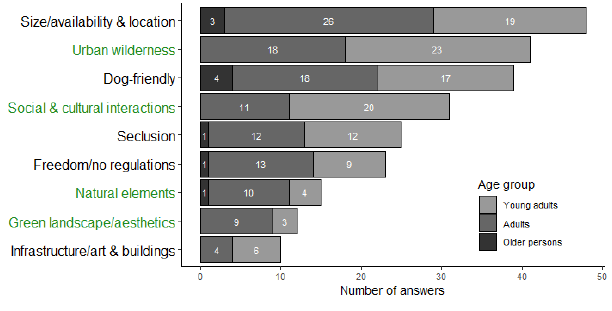
Fig. 4 . Frequencies of perceived benefits (categorized answers from open question) on brownfields mentioned by visitors of different age groups on our study sites in Leipzig. Multiple answers were possible. The white numbers display the number of anwers for each age group. Nature benefits are written in